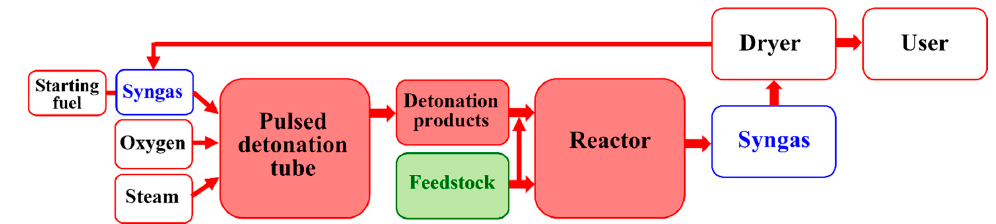
Figure 1. Schematic of organic-waste gasifier operating on pulsed detonation gun technology.